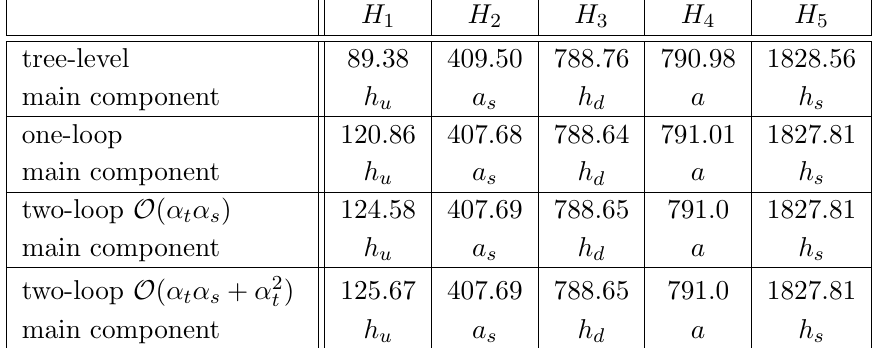
) obtained by using DR renormalization t